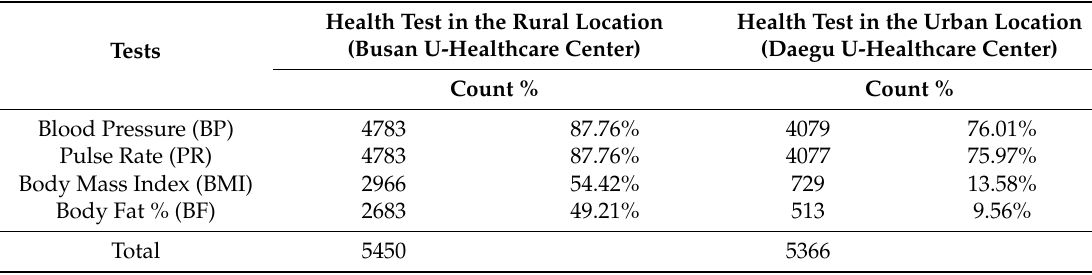
Table 2. Health test preferences of users at U-Healthcare